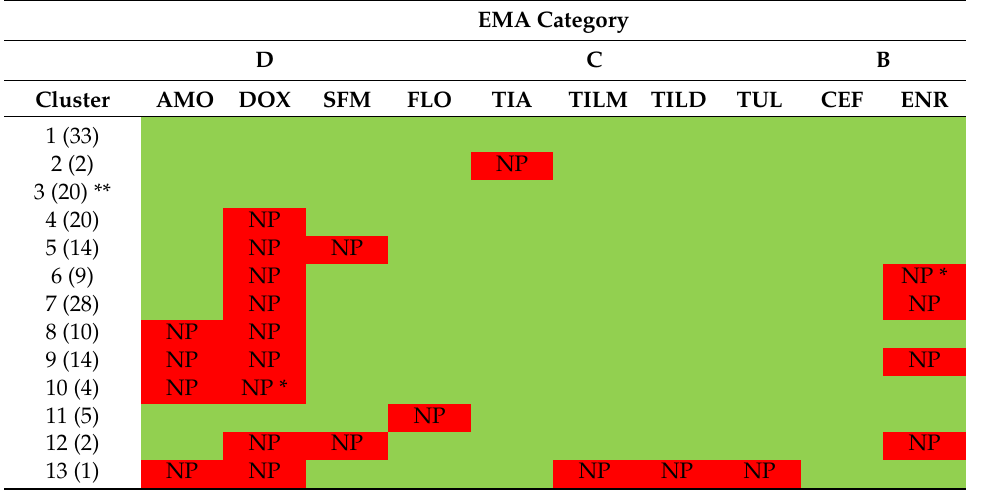
Table 1. Antimicrobial susceptibility pattern for the 13 clusters obtained from 162 Actinobacillus pleuropneumoniae isolates after a hierarchical clustering analysis. It is detailed in brackets the number of strains belonging to each cluster. Suitable antimicrobials are detailed in green color. The antimicrobials tested included amoxicillin (AMO), ceftiofur (CEF), doxycycline (DOX), enrofloxacin (ENR), florfenicol (FLO), sulfamethoxazole / trimethoprim (SFM), tiamulin (TIA), tilmicosin (TILM), tildipirosin (TILD), and tulathromycin (TUL).